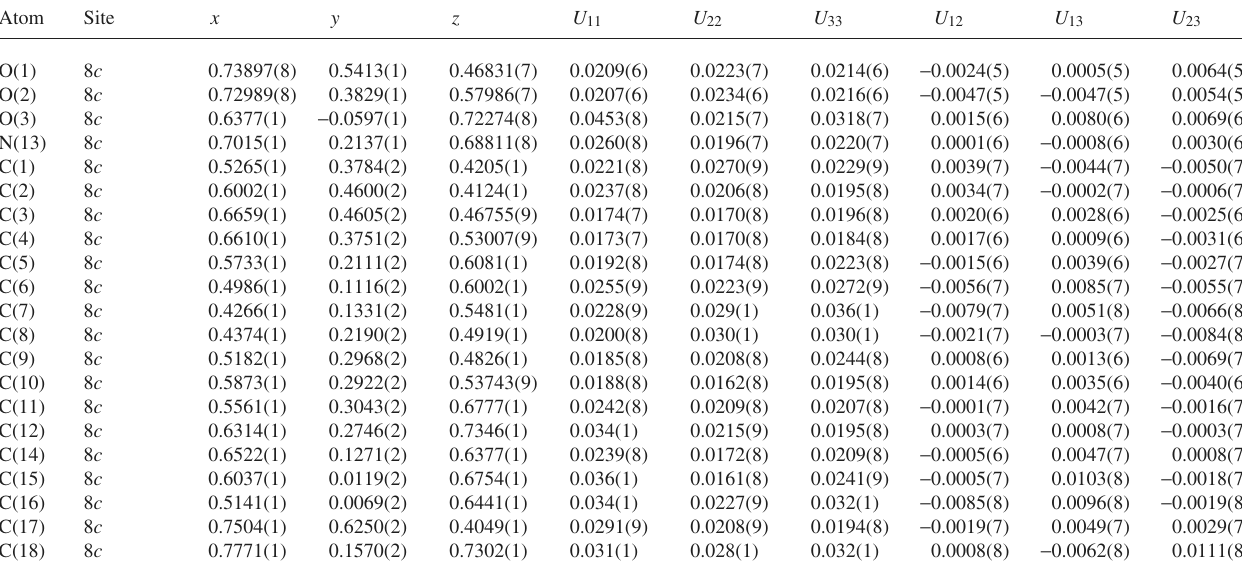
Table 3. Atomic coordinates and displacement parameters (in Å 2 )